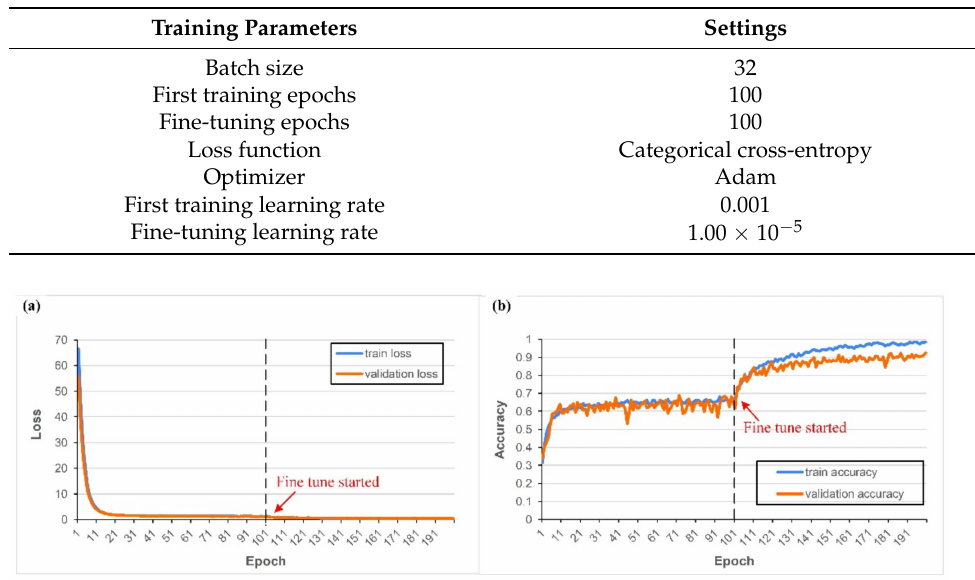
Figure 19. The loss ( a ) and accuracy ( b ) of the model of the third